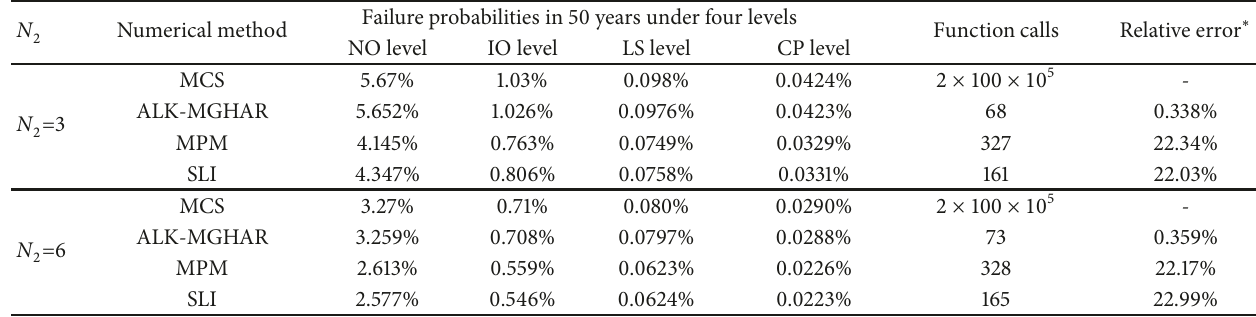
Table 5: Results with different values of N 2 by different methods.